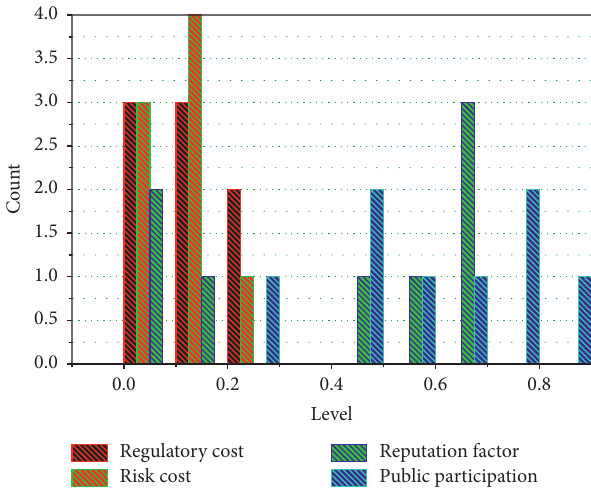
Figure 8: Marginal regulatory and risk costs, reputation coefficient, and public engagement.